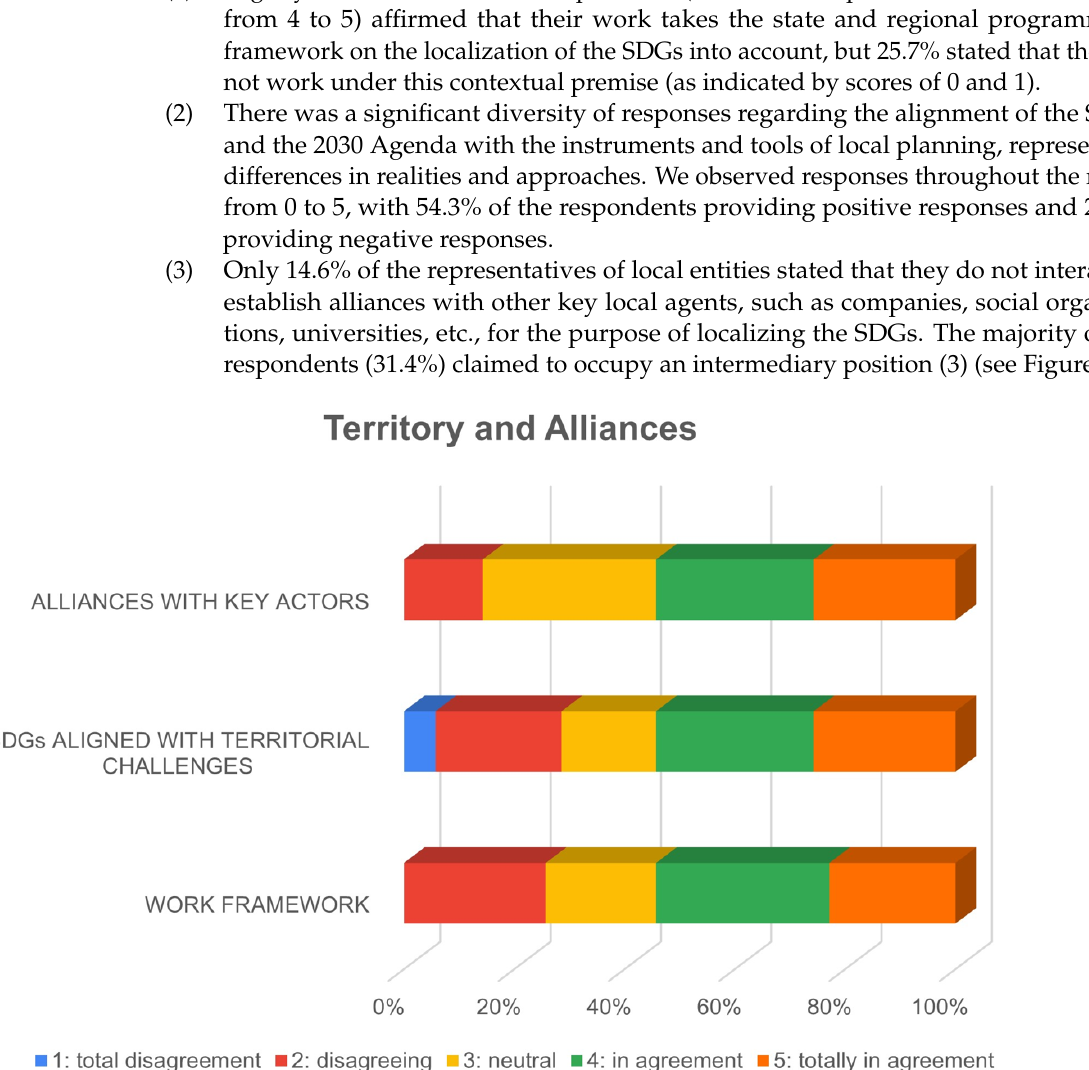
Figure 5. Territory and